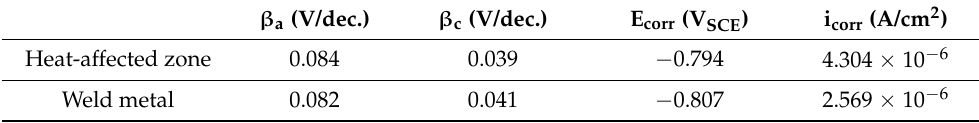
Table 3. Experimental conditions and calculated variables.